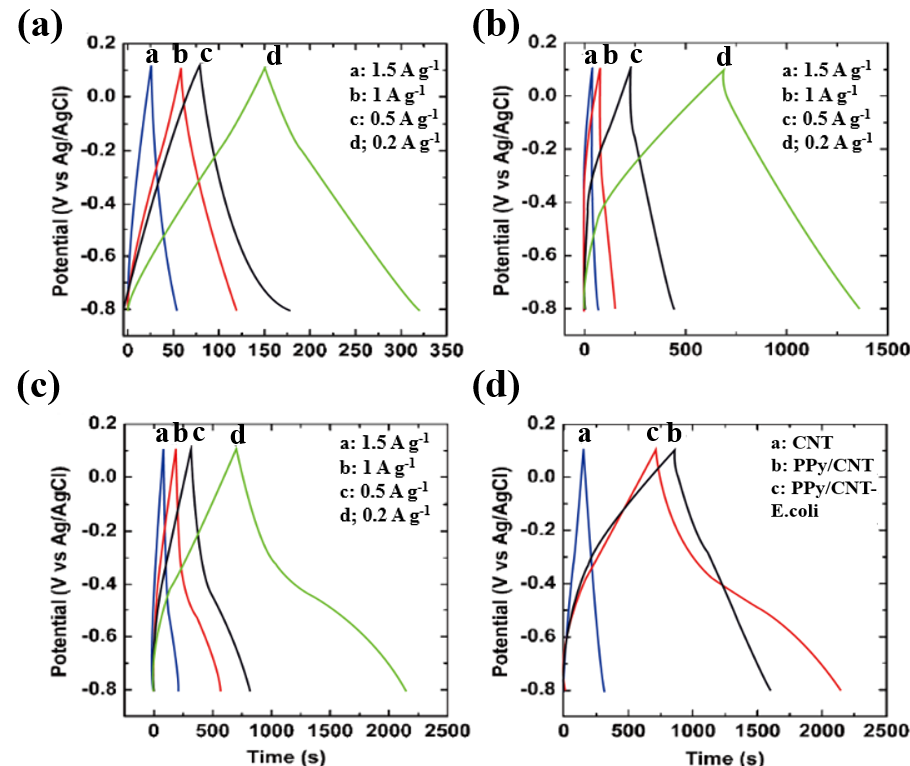
Figure 5. Galvanostatic charge/discharge curves of ( a ) CNT, ( b ) PPy/CNT, ( c ) PPy/CNT– E. coli , and ( d ) CNT, PPy/CNT and PPy/CNT– E. coli for comparison at 0.2 A · g –1 . Table 2. Specific capacitance values of CNT, PPy/CNT, and PPy/CNT– E. coli calculated from Gal- vanostatic charge/discharge (GCD) curves.